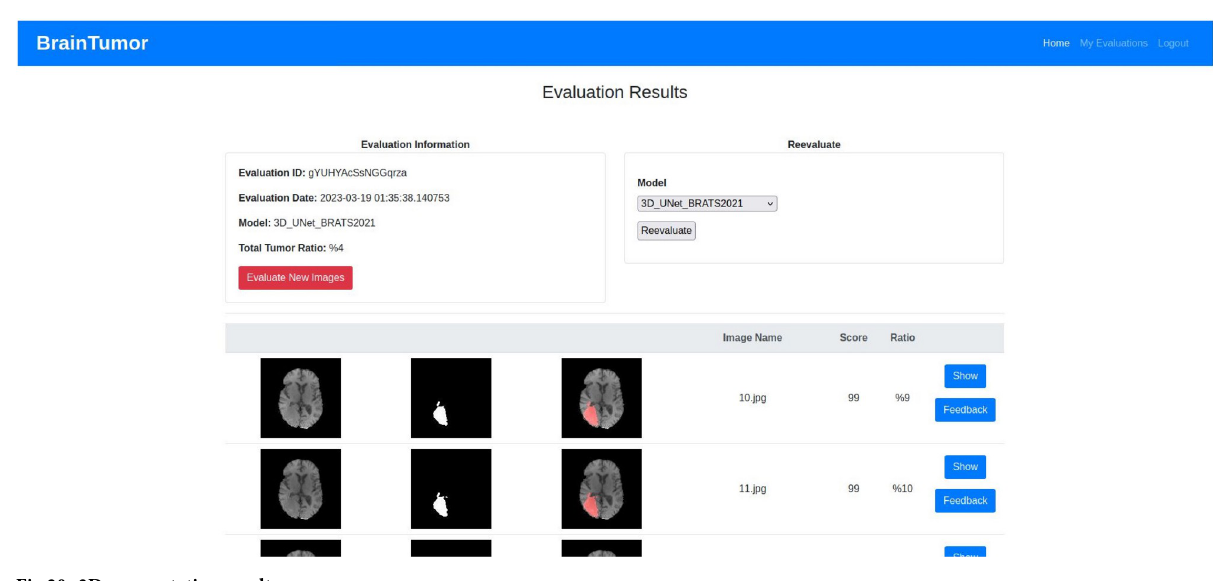
Fig 20. 3D segmentation results page. and non-tumor regions and these intensities are not consistent. In some images the tumor region intensity is higher than the rest of the image, in some images it is lower, and it is not dis- tinguishable in others. The 2D dataset has images that include the skull, brain and tumor and the differences between these are not prominent. The 3D dataset is a processed benchmark dataset containing all axial view 3D MRIs with skull-stripped brain images and the tumor regions are distinguishable in almost all files. The 2D slices collected from the 3D files also